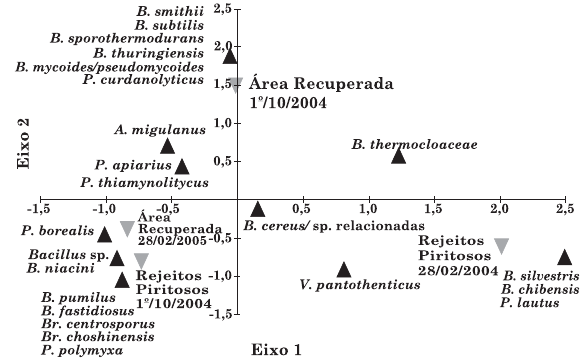
Figura 1. Ocorrência das rizobactérias formadoras de endósporos nos locais e datas de coleta por meio da análise de